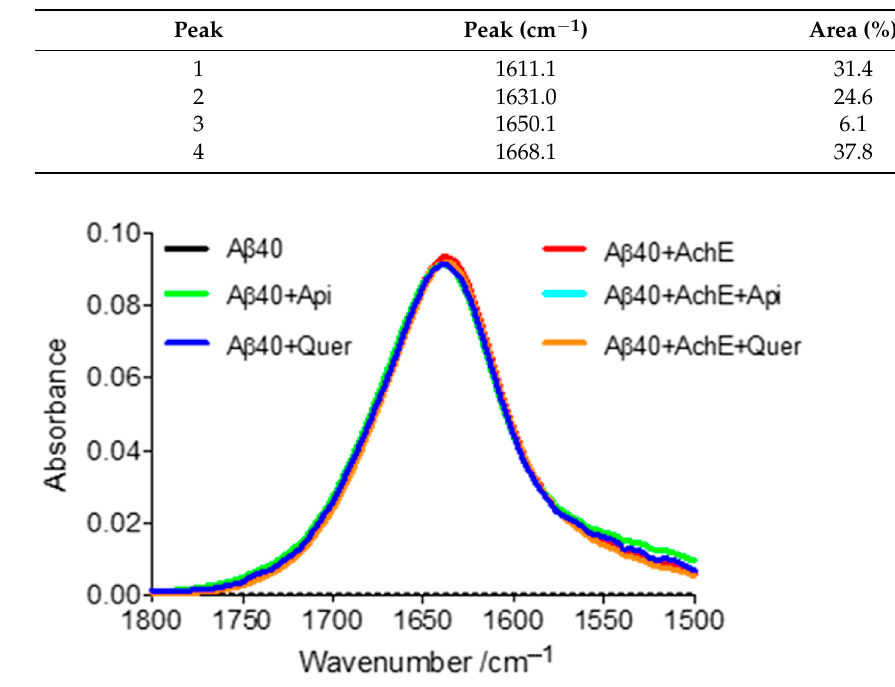
Figure 7. FTIR patterns centered in the amide I region of A β 40 for different samples after 24 h of incubation. Black spectrum: free A β ; green spectrum: A β + apigenin; dark-blue spectrum: A β + quercetin; red spectrum: A β + AChE; light-blue spectrum: A β + AChE + apigenin; orange spectrum: A β + AChE + quercetin.